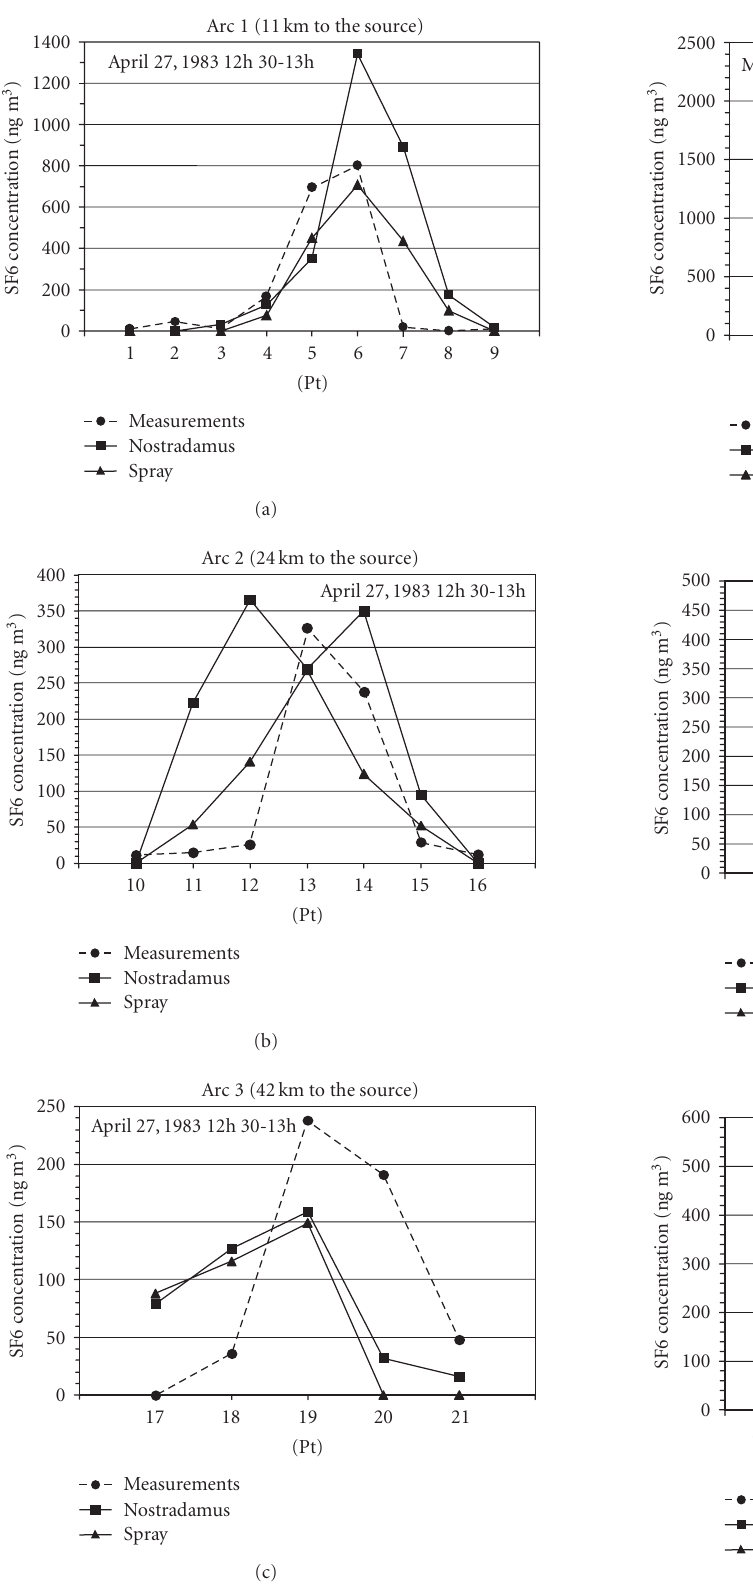
Figure 3: Comparison of SF6 concentration during experiment 1 on three arcs of monitoring points between measurements (at 1 meter above ground level) and NOSTRADAMUS and SPRAY cal- culations (at 10 meters above ground level).